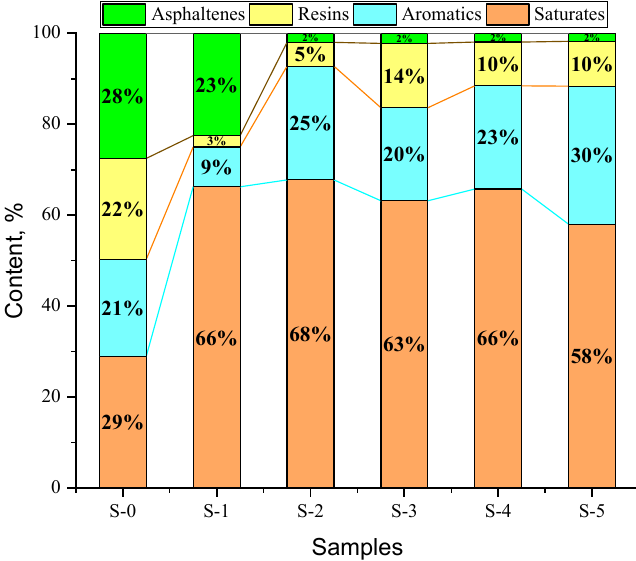
Figure 4. SARA analysis of extra-heavy oil and upgraded oil samples.